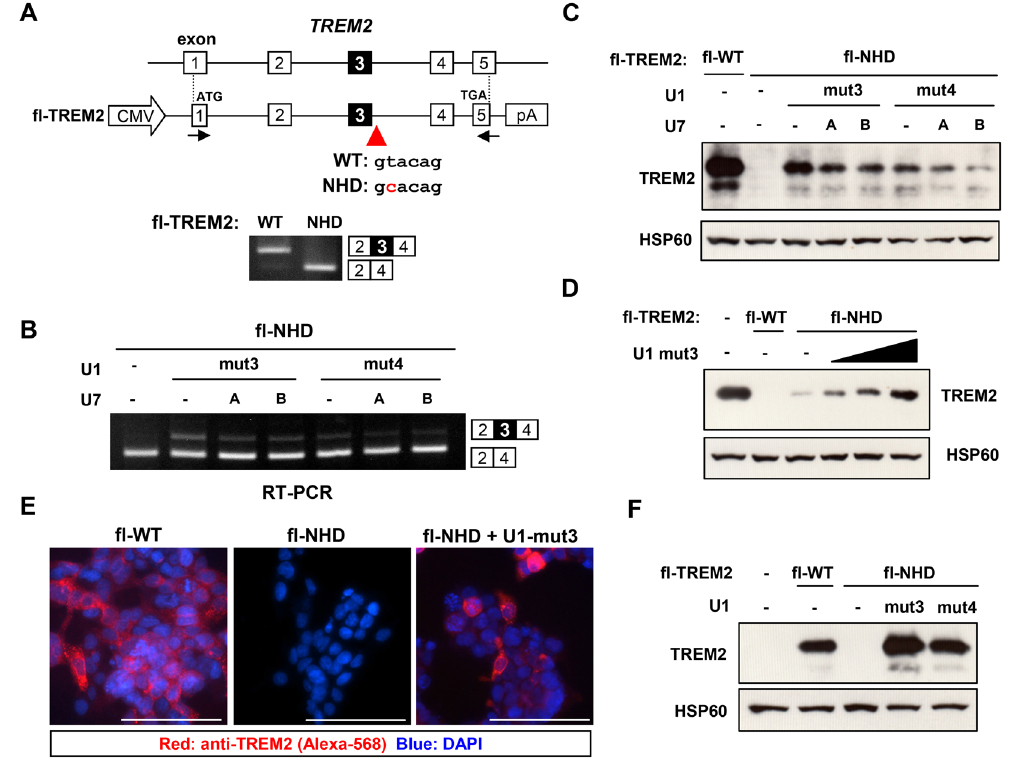
Figure 3. Modified U1 snRNA-mediated correction of TREM2 mis-splicing associated with NHD. ( A ) Structure of the fl-WT and fl-NHD minigenes integrated into the genome of HEK293 cells using the Flp-In system. Congenic cell lines stably harboring either minigene were established. The splicing pattern of TREM 2 in these cell lines are shown at the bottom. ( B ) TREM2 splicing patterns of the fl-NHD cells. For fl-NHD cells, transfection of U1mut3 induced the spliced product containing exon 3. ( C ) Western blot analysis of fl-WT and fl-NHD cells and parental HEK cells. Either U1mut3 or U1mut4 were co-transfected with U7A and/or U7B into fl-NHD cells. HSP60 was used as a loading control. ( D ) U1mut3 dose-dependently induced TREM2 protein expression in fl-NHD cells. Increasing amounts of U1mut3 were transfected into fl-NHD cells and TREM2 expression was detected by western blotting. ( E ) Immunofluorescence of fl-WT and fl-NHD cells using an anti-TREM2 antibody (red). U1mut3 induced TREM2 protein expression in fl-NHD cells. Nuclei were stained with DAPI. Scale bar: 100 μ m. ( F ) Transient co-expression of U1mut3 and fl-NHD restored TREM2 protein expression. HEK cells transfected with the indicated constructs were analyzed by western blotting. Original gel images and western blot data are shown in Supplementary Fig.